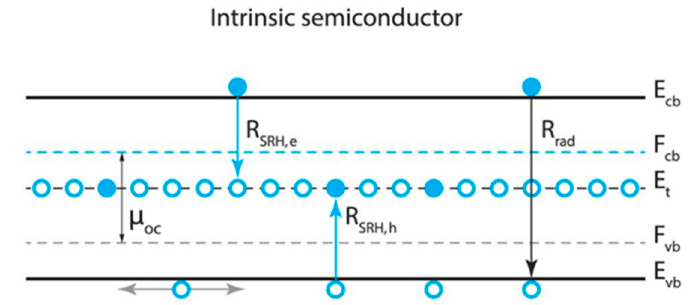
Figure 2. Electron and hole energetics and recombination. The free energy µ oc of photogenerated electron-hole pairs at the open circuit (oc) is equal to the energy splitting of the quasi-Fermi level conduction ( F cb ) and valence ( F vb ) bands. The trap level ( E t ) in the mid-gap is empty from where Shockley-Read-Hall recombination of electrons (holes), R SRH,e ( R SRH,h ), occurs. Reproduced with permission from Sci. Rep. 2017 , 7 , 44629 . Reference [6].